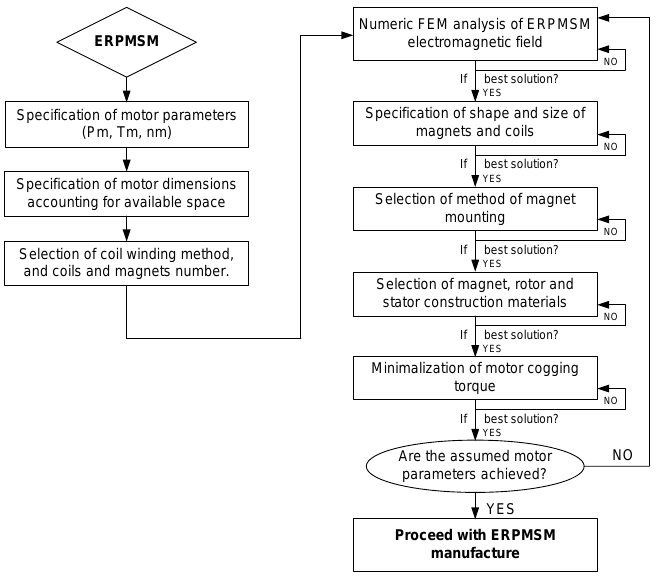
Figure 2. Methodology of the ERPMSM design.